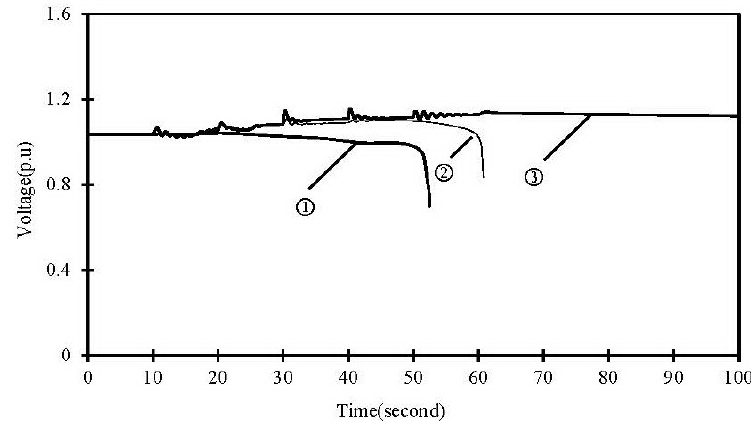
Figure 11. Voltage curve of key bus